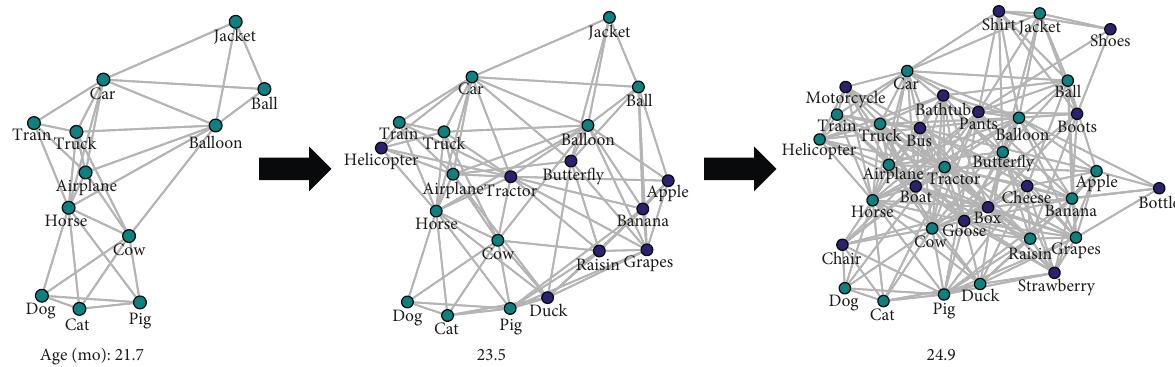
Figure 3: Network representation of a child’s growing productive vocabulary.